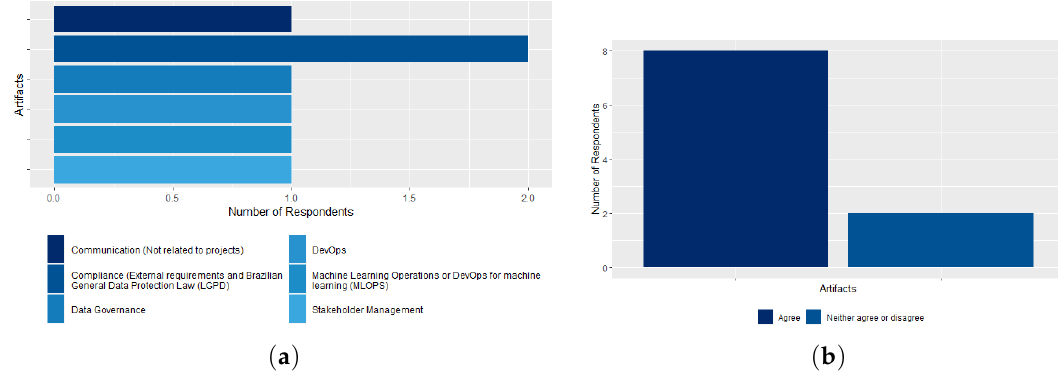
Figure 21. ( a ) The artifacts suggested by CGTI workers to be added to the CADE context; ( b ) the perception of CGTI workers in relation to the adherence of ICT processes to